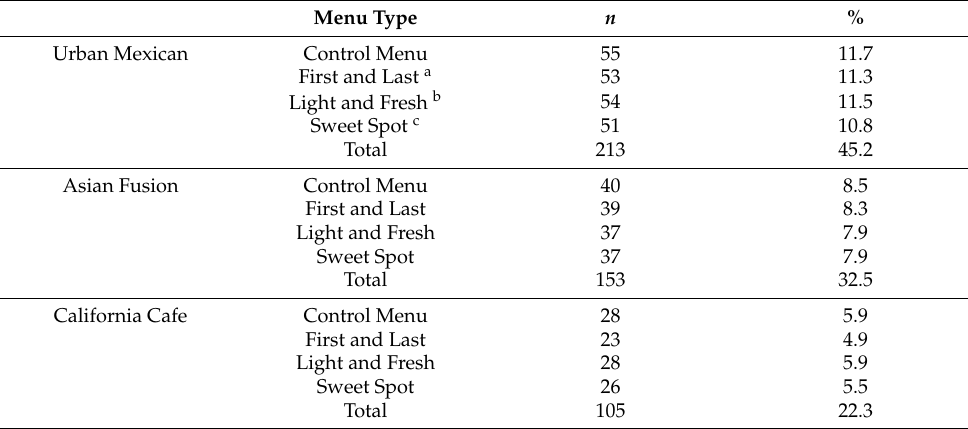
Table 3. Subjects’ restaurant choices and random menu